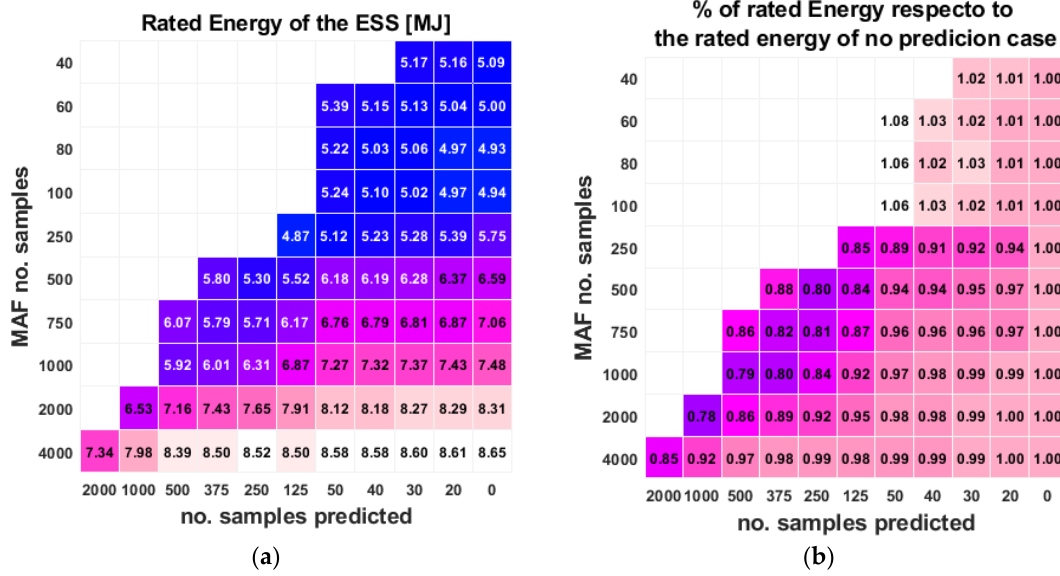
Figure 13. ( a ) ESS energy rating matrix for di ff erent MAF filters (window length “nMAF” and number of samples predicted “nP”); ( b ) % of rated energy with respect to energy rating with no predicted samples.